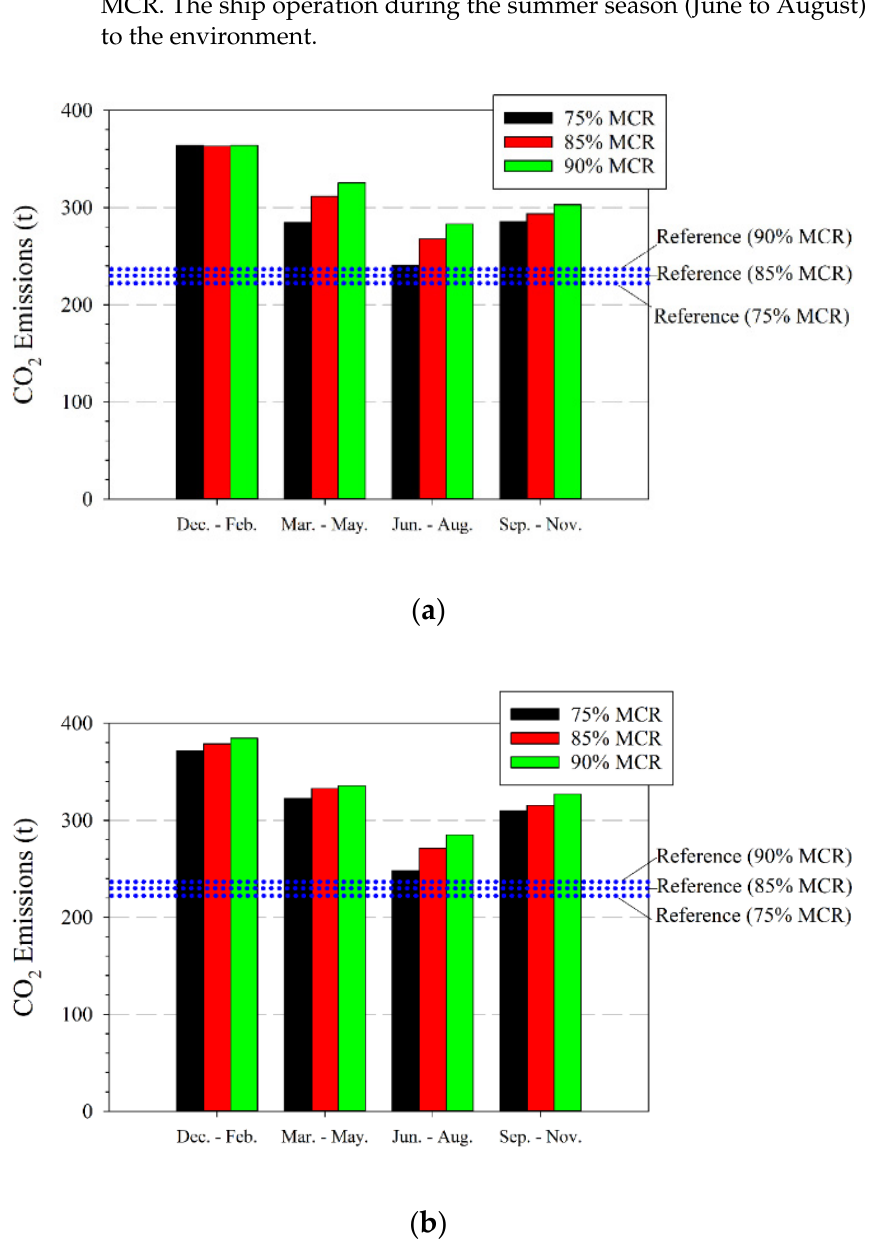
Figure 17. CO 2 emissions per MCR and per seasons compared with reference lines (blue) of calm waters. ( a ) Load Condition 1. ( b ) Load Condition 2. Source: Own elaboration.